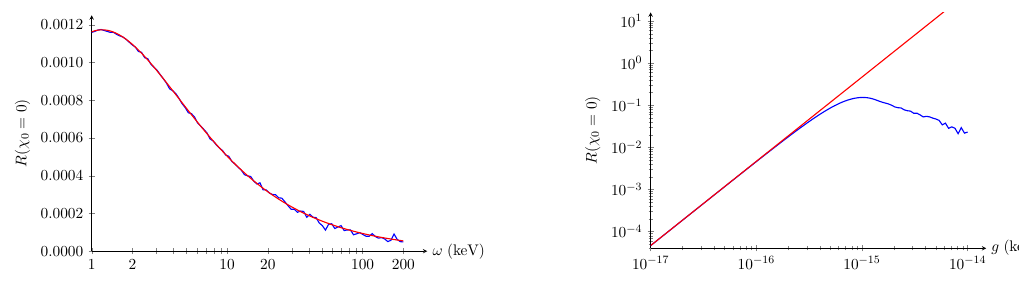
Figure 2 . Normalized surface-subtracted Stokes parameter R for pure ALP initial state as a function of ! and g . The blue lines are obtained from the evolution equations (2.3) while the red lines correspond to the approximation (4.3). The benchmark values of the ALP-photon coupling and magnetar parameters are m a = 10 (cid:0) 8 keV, r 0 = 10 km, B 0 = 20 10 14 G and (cid:18) = (cid:25)= 2. For the (cid:2) left panel g = 5 10 (cid:0) 17 keV (cid:0) 1 , while for the right panel ! = 1 (cid:2)